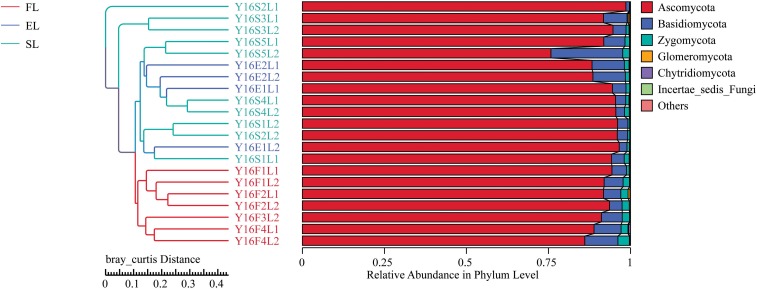
UPGMA poly-tree of black locust in different habitats. This indicates the relationship between different groups. Results are mean of replicates ± standard deviation. UPGMA, unweighted pair-group method with arithmetic means; FL, black locust in forest habitat; FN, native plants in forest habitat; EL, black locust in forest-steppe habitat; EN, native plants in forest-steppe habitat; SL, black locust in steppe habitat; SN, native plants in steppe habitat.